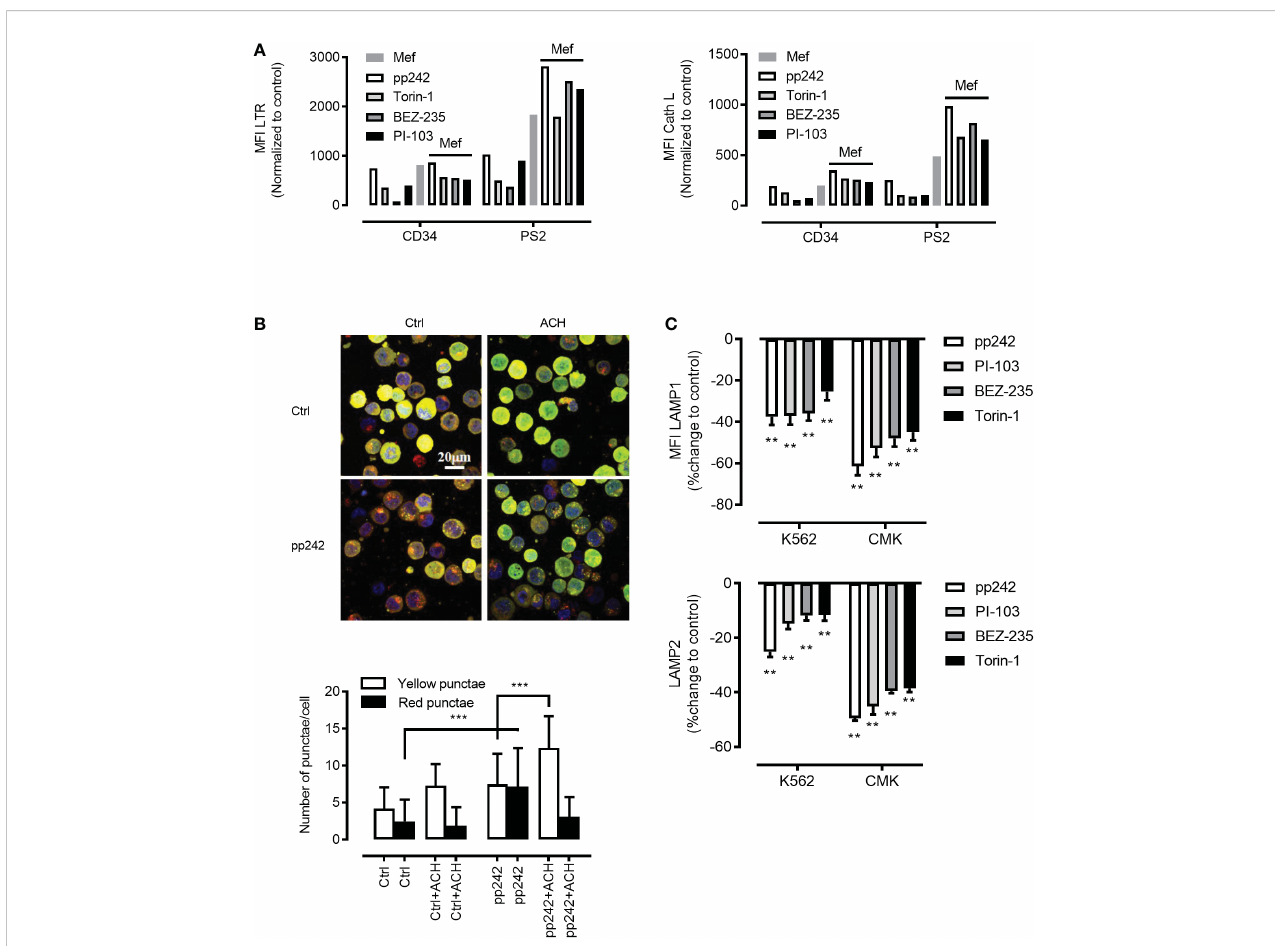
FIGURE 3 Me fl oquine synergistically activates lysosomal biogenesis in combination with mTOR inhibitors. (A) Patient 2 derived leukemic blasts (PS2) and healthy CD34+ cells were treated with the synergistic combination of mTOR inhibitors such as pp242 (5µM), Torin-1 (5µM), BEZ-235 (5µM), PI-103 (5µM) with and without me fl oquine (Mef) (10µM) for 12 h and LTR ( left panel ) and Cath L ( right panel ) were measured by fl ow cytometry. The measurements represented in the bar graph were normalized to respective untreated controls. LC3-GFP-mCherry expressing K562 cells were treated with mTOR inhibitor pp242 (5 m M), for 6 h in the presence and absence of ammonium chloride (ACH) (5mM) for 4 h (B) Images above and quanti fi cation below . Images are representative of two independent experiments with more than 3 images taken randomly per condition per experiment. (C) K562 and CMK cells were treated with various mTOR inhibitors such as pp242, PI-103, BEZ-235 and Torin-1 at 5 m M concentration for 24 h and were intracellularly stained with LAMP1 ( upper panel ) or LAMP2 ( lower panel ) and analyzed on the fl ow cytometer. Data are compared to untreated controls, represented as mean ± S.D. and percent change to control. Data are representative of two independent experiments with 2 replicates. Two-way ANOVA with Sidak ’ s multiple comparison test showed signi fi cant (**p<0.01) downregulation of these two proteins when compared to untreated controls in each cell line. ***P <